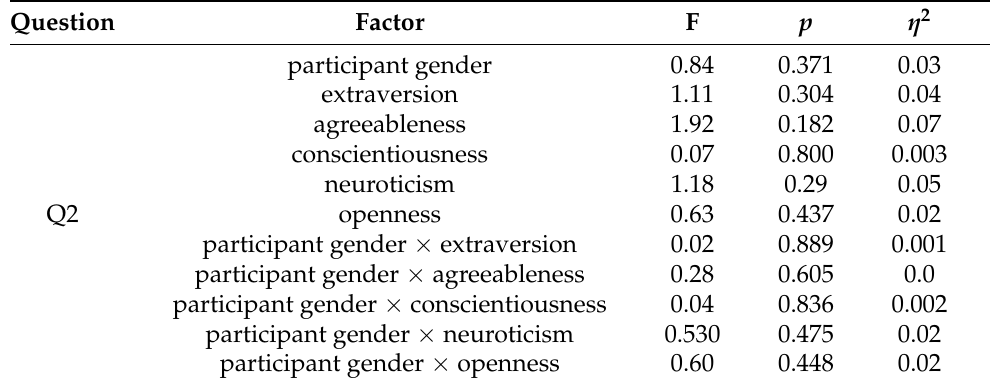
Table A2. GLM analysis of the effect of participants’ personality traits (i.e., extraversion, agreeable- ness, conscientiousness, neuroticism, openness) on their responses to question